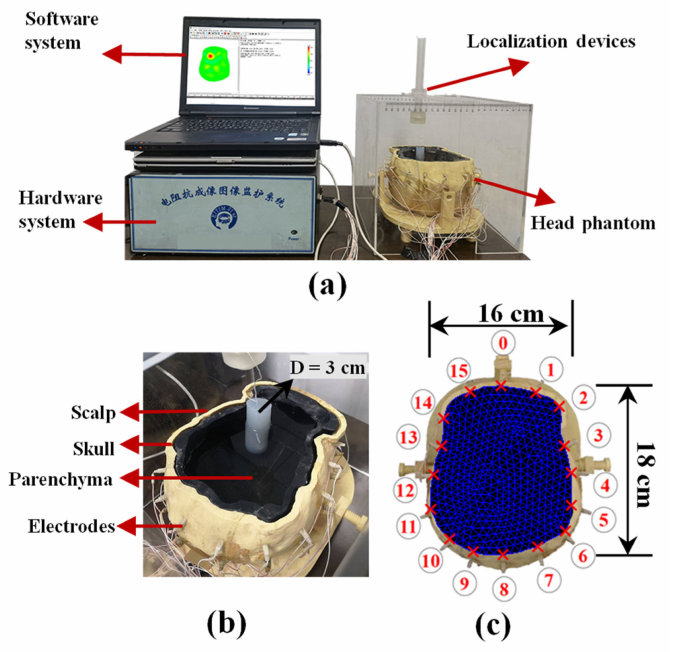
Figure 3. Head phantom experimental setup. ( a ) Head phantom experimental platform. ( b ) Head phantom model with actual anatomical structure and conductivity distribution containing 16 elec- trodes and cylindrical agar block as a simulated lesion. ( c ) Finite element model for reconstruction, matching the plane of the electrode in the head phantom. (D: diameter; “red crosses”: electrode locations; “circled numbers”: electrode